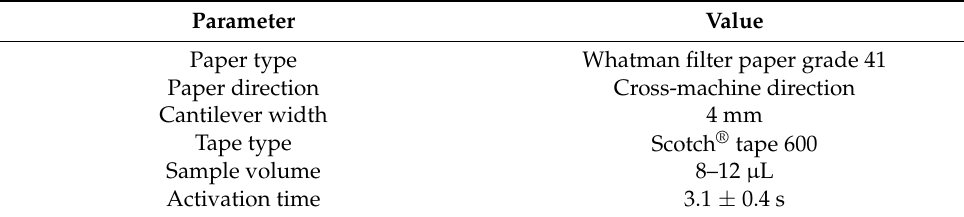
Table 1. Summary of optimal geometric and material parameters, along with corresponding activation time, for a